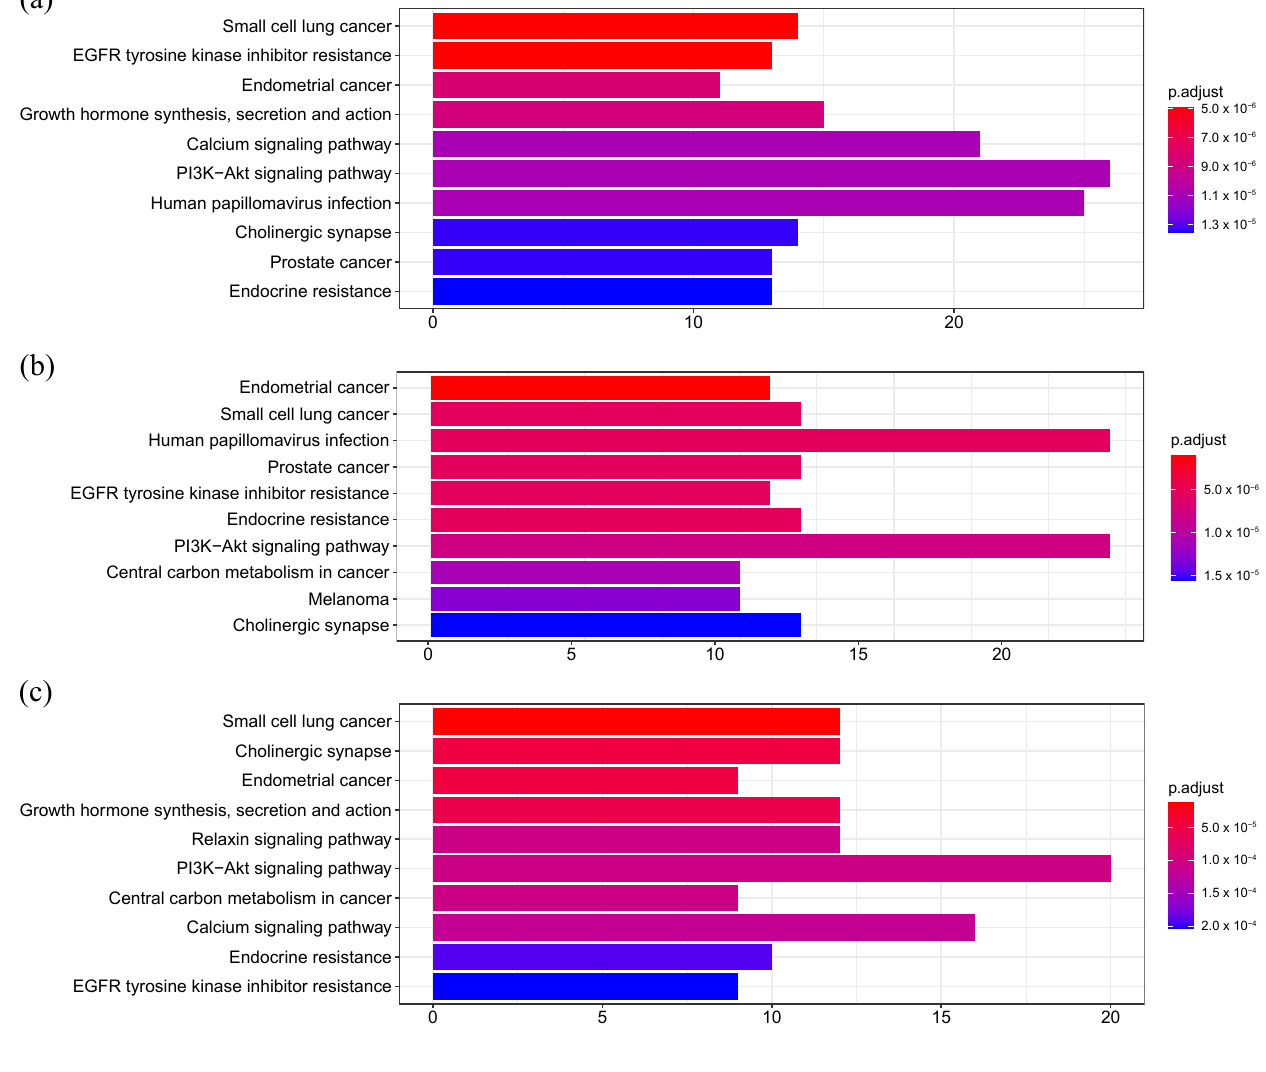
Figure 2. KEGG analyses for mutated genes from three subsets. ( a ) Enriched pathways for overall mutated genes. ( b ) Enriched pathways for baseline mutated genes. ( c ) Enriched pathways for mutated genes after chemotherapy. Top 10 pathways were shown. Length of each column indicates number of enriched genes, and color of bars represents statistical